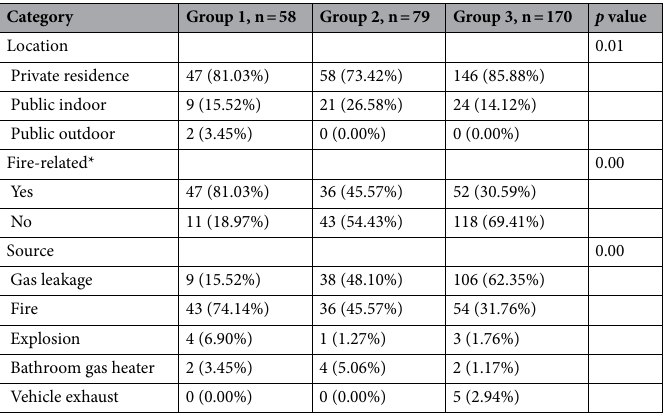
Table 3. Distribution of the CO poisoning cases by death circumstances. *Defines the cases with acute CO poisoning as the cause of death in circumstances of fire burn incidences.